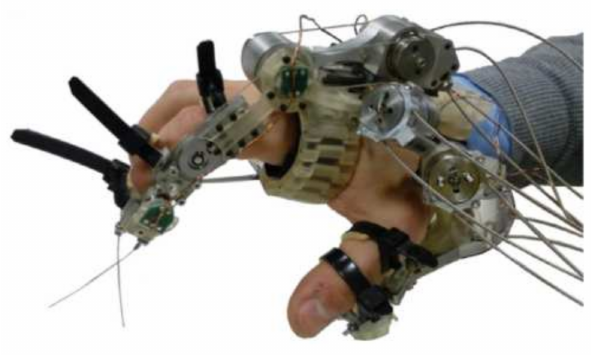
Figure 4. Close-up view of the HX- β orthosis (exoskeleton)